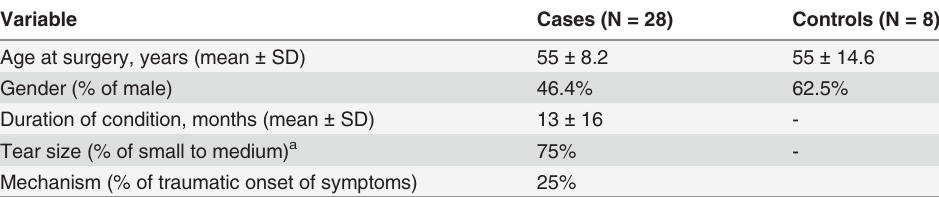
Table 1. Distribution of the clinical outcomes of rotator cuff tear patients and controls.